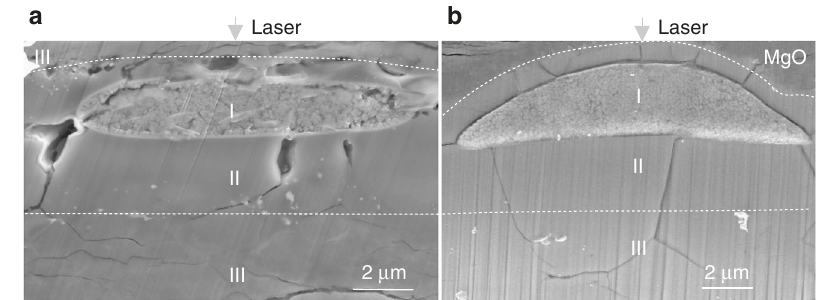
Fig. 1 SEM images of representative cross sections of recovered ferropericlase melted samples. Samples melted at a 60 GPa (Jul0415) and b 27 GPa (Fp2002). Both images show a clearly quenched melt (I), co-existing solid that is relatively iron depleted (II), and starting material (III) regions. The starting material used in the left panel [(Mg 0.81 , Fe 0.19 )O] was self-insulated whereas the starting material used in the right panel [(Mg 0.20 , Fe 0.80 )O] was insulated by pure MgO. (Mg 0.20 ,Fe 0.80 )O reacted with MgO, generating a more Mg-rich melt and coexisting solid compared with the